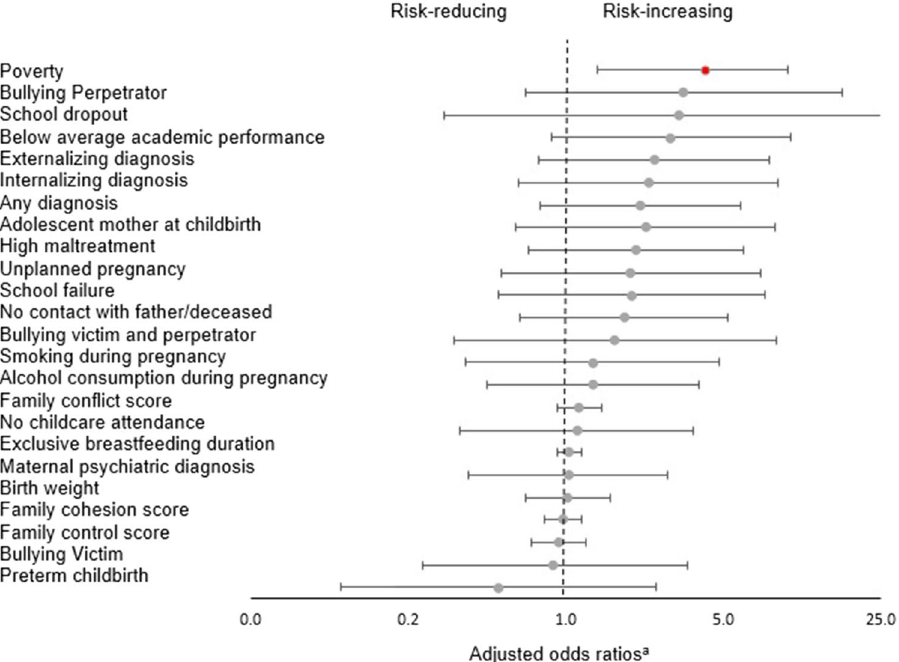
Figure 1. Childhood individual and family modifiable risk factors of criminal conviction, adjusted odds ratios and 99.8% confidence intervals. a Adjusted by sex, age, city, ethnicity, and intelligence quotient. The dash vertical line represents Odds Ratios = 1.00. The red point indicates a significant estimate at P <